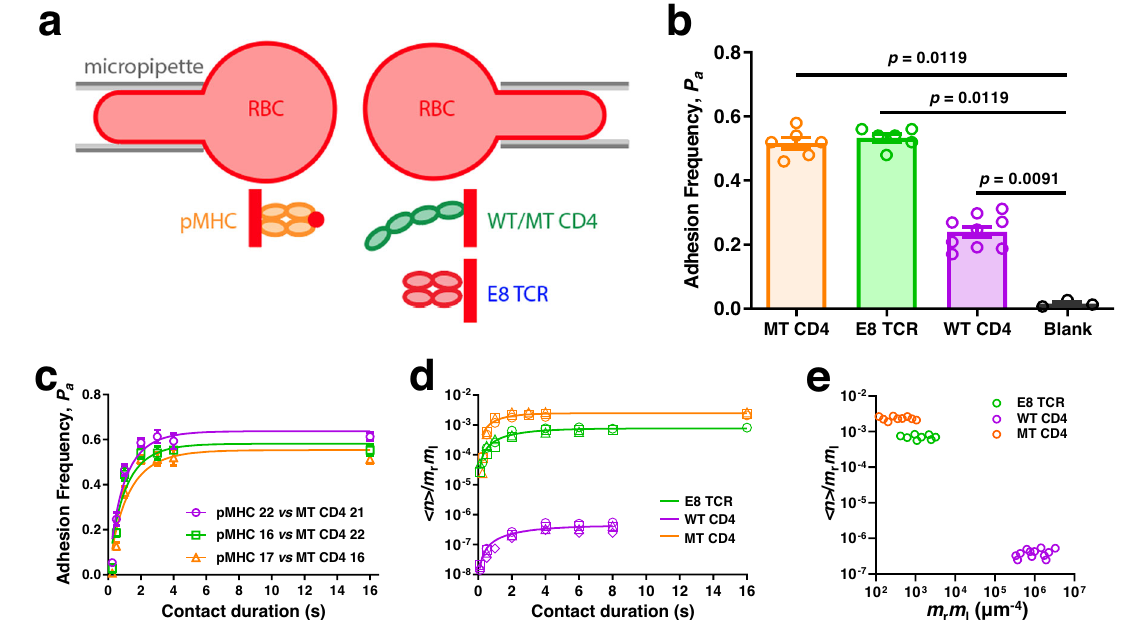
Fig. 1 | 2D kinetic analysis of TPI:HLA-DR1 interaction with E8 TCR or CD4. a Schematicsof micropipette binding frequencyassay( top )and molecularcoating ( bottom ). A pMHC-coated RBC ( left ) was repeatedly brought into contact with an opposing RBC coated with E8 TCR, or WT/MT CD4 (right) and separated to detect bond formation across the contact interface. b Speci fi city is shown by the sig- ni fi canthigher(p-valueindicated,bytwo-tailedMann-Whitneytest)ofsteady-state (contacttime t c =4s)adhesionfrequencies( P a ,mean±SEM( n =6,6,9,3cellpairs) of indicated points each determined from 50 cycles of contact) between pMHC- coatedRBCsandRBCscoatedwithE8TCR,WTCD4,orMTCD4,thanthatwithout